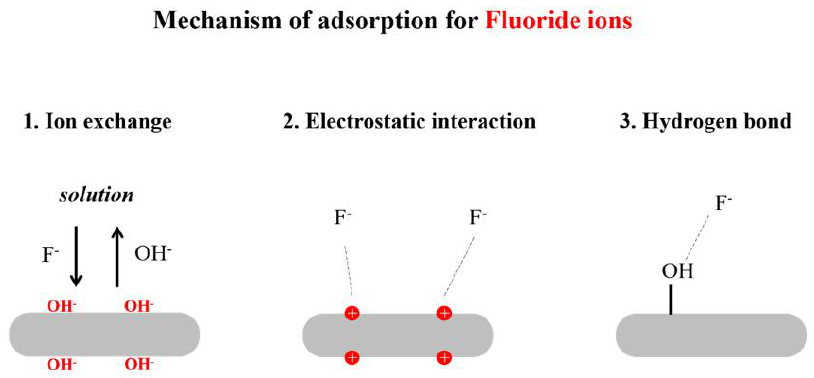
Figure 4. Adsorption mechanism of HAp for fluoride ions.